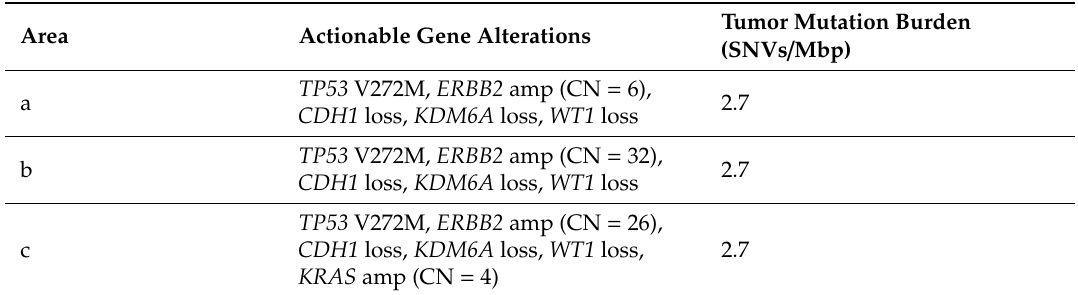
Figure 2. Immunohistochemical HER2 assessment. Region a (left panel): 1+, region b (middle panel): 3+, region c (right panel) (×200). Table 1. Detailed information regarding actionable gene alterations in three tumor regions.